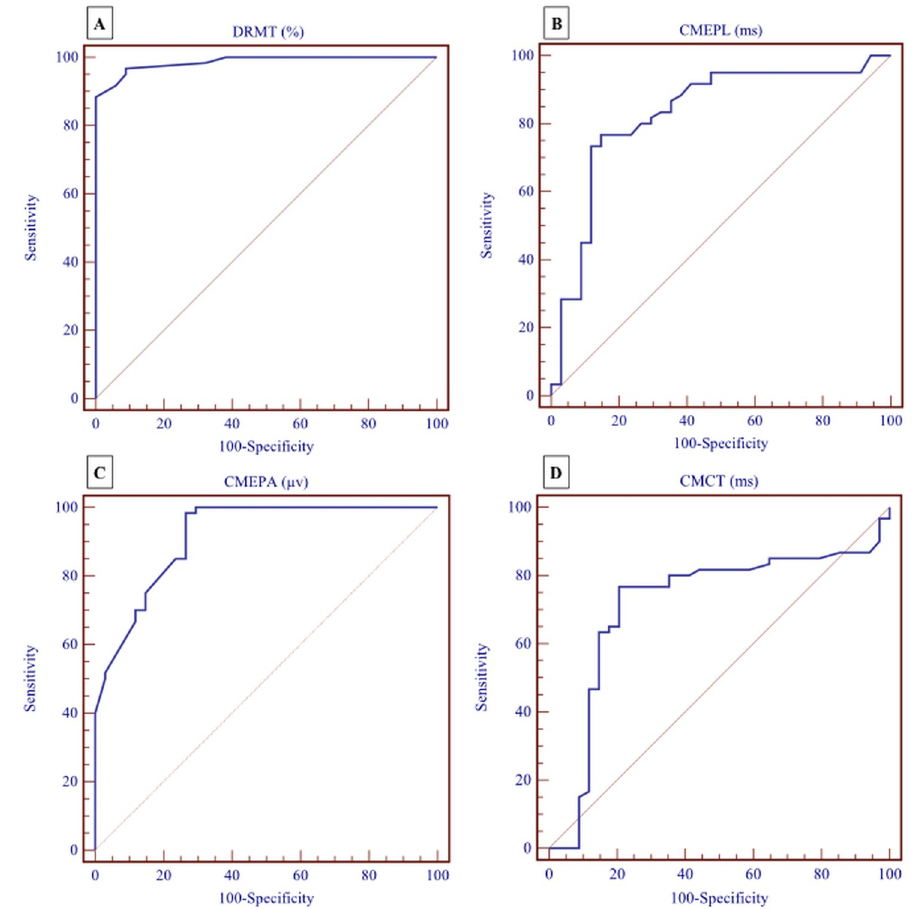
CI95% = 0.612–0.803, p = 0.0001). (D) CMCT (AUC = 0.916, CI95% = 0.841–0.963, p =